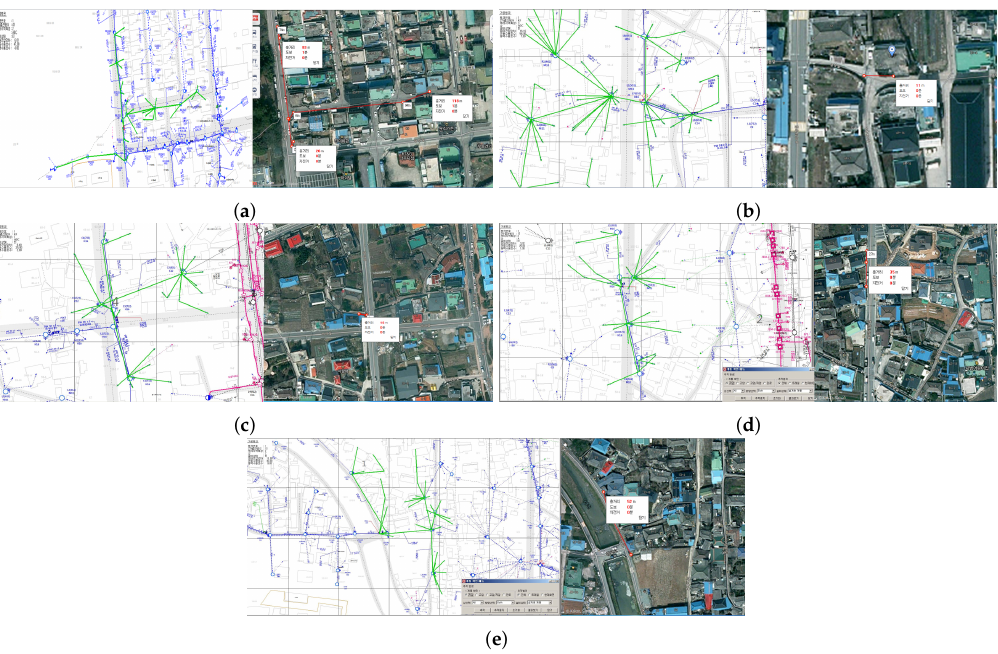
Figure 14. New Distribution Information System (NDIS) maps for the Overhead Residential Area.